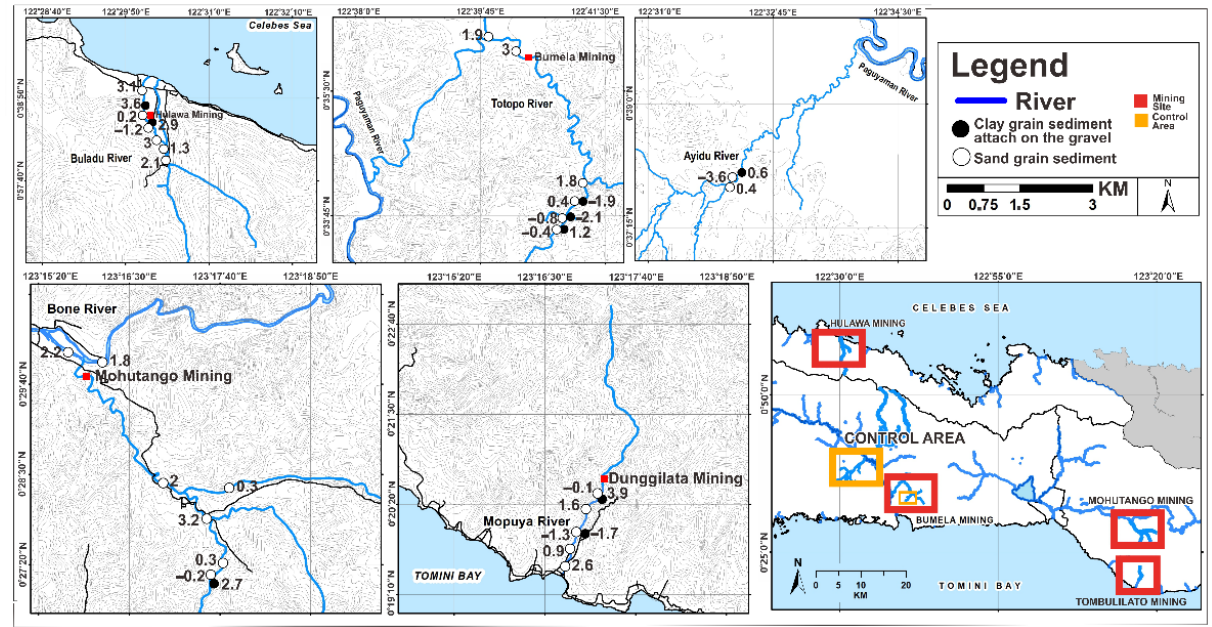
Figure 4. Plots of I geo and contaminant levels in Pb along the river sediments in Gorontalo Province, Indonesia (µg/g).